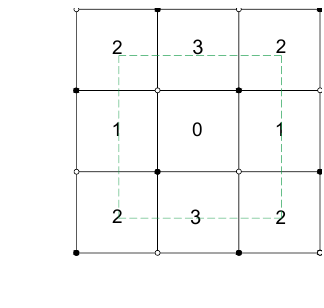
Figure 16. The quiver of the eletric phase of C = Z 0 dimer is on the right.